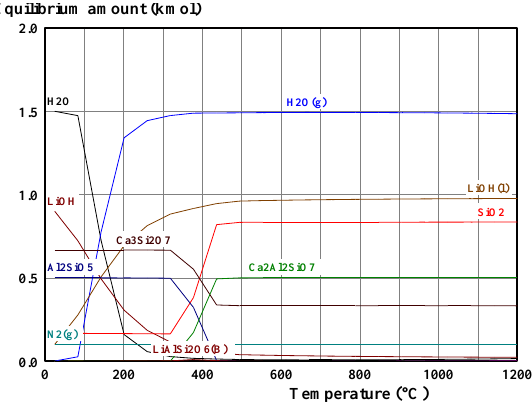
Figure 3. Equilibrium amounts versus temperature for sulfate roasting of spodumene using ( a ) Na 2 SO 4 , ( b ) K 2 SO 4 , ( c ) H 2 SO 4 , ( d ) SO 3(g) , ( e ) Fe 2 (SO 4 ) 3 and ( f ) Al 2 (SO 4 ) 3 (data from HSC Chemistry 5.1 software).